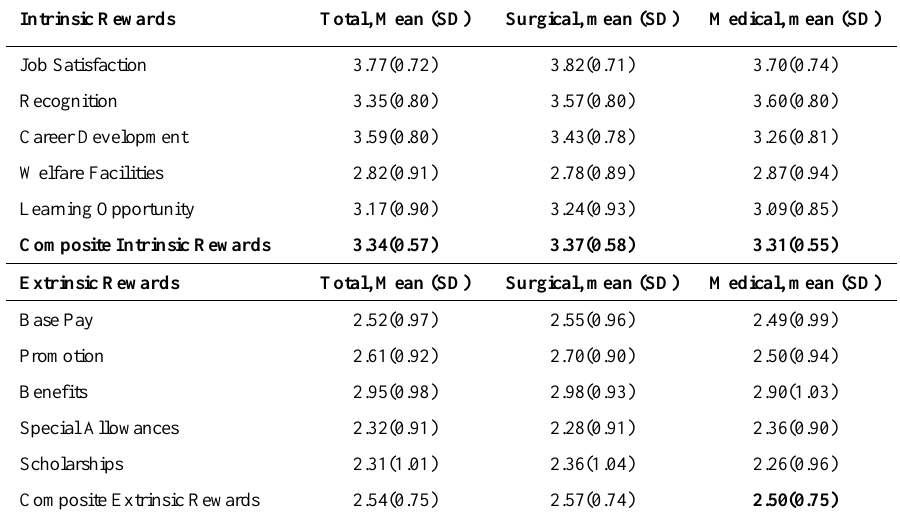
Table 1. Mean Score for Intrinsic Rewards and Extrinsic Rewards